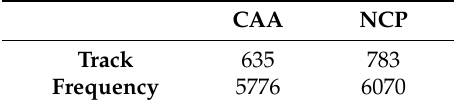
Table 1. The sum of IC tracks and IC frequencies in spring from 1979 to 2015.